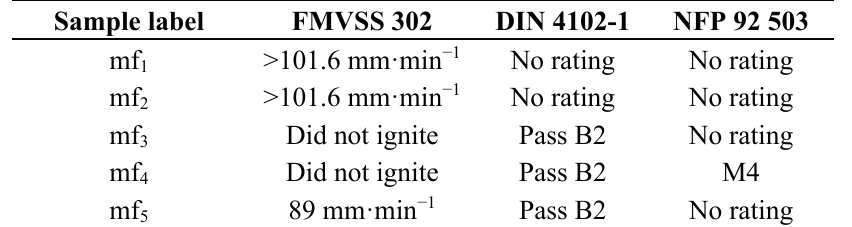
Table 7. Ranking of the samples according FMVSS 302, DIN 4102-1 and NFP 92,503 tests. Sample